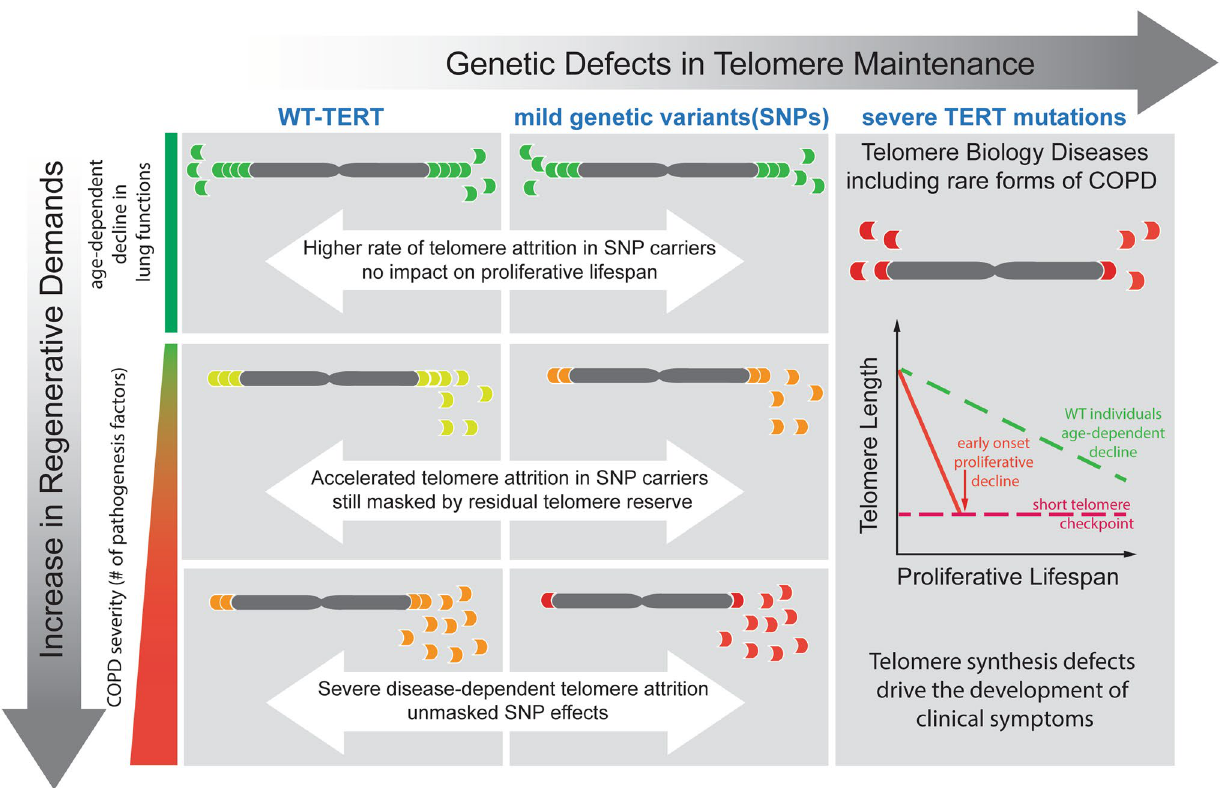
Figure 3. The impact of genetic defects in telomere maintenance on lung function deterioration. Telomere Biology Diseases (TBD, right panel) are caused by rare genetic mutations that severely compromise the synthesis and/or the structural protection of the telomeres. TBD patients display extremely short telomeres at a young age, precipitating the onset of clinical symptoms. In contrast, carriers of common TERT genetic variants (SNPs) (middle panel) are not expected to display pathogenesis associated with short telomeres in the absence of additional factors (environmental, pathological or in combination with other genetic determinants) that accelerate telomere attritions. Even so, these carriers are still genetically predetermined to a decreased capacity to maintain their telomeres, when compared with noncarriers (left panel). These deficiencies,